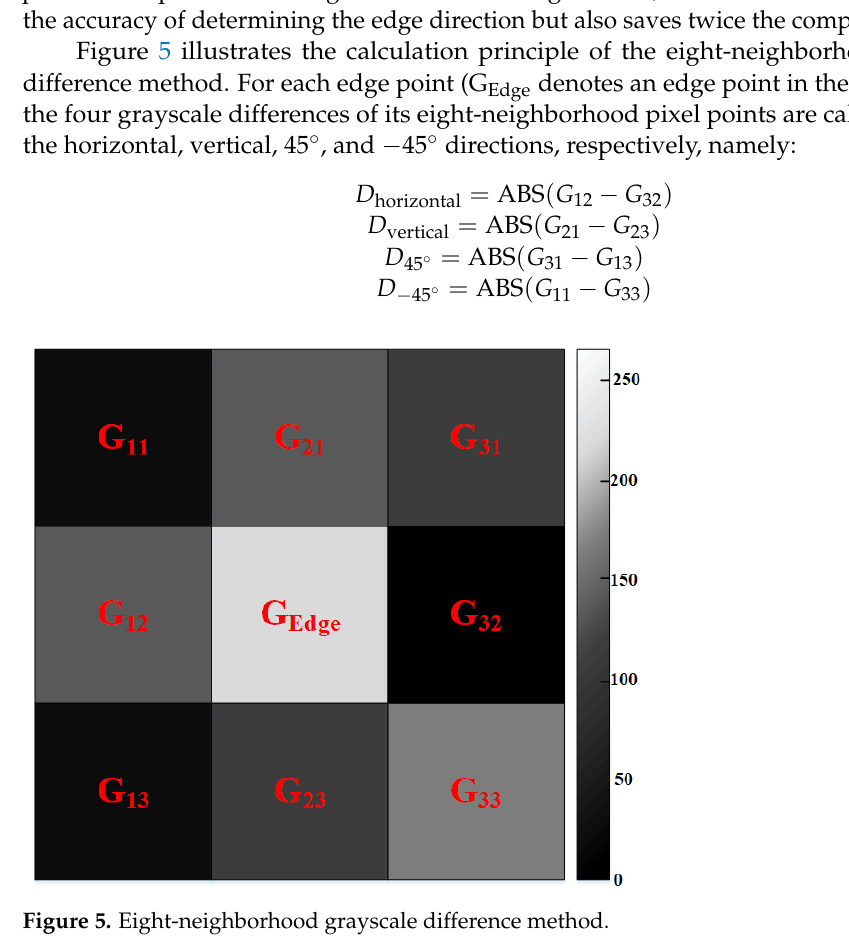
Figure 5. Eight-neighborhood grayscale difference method.